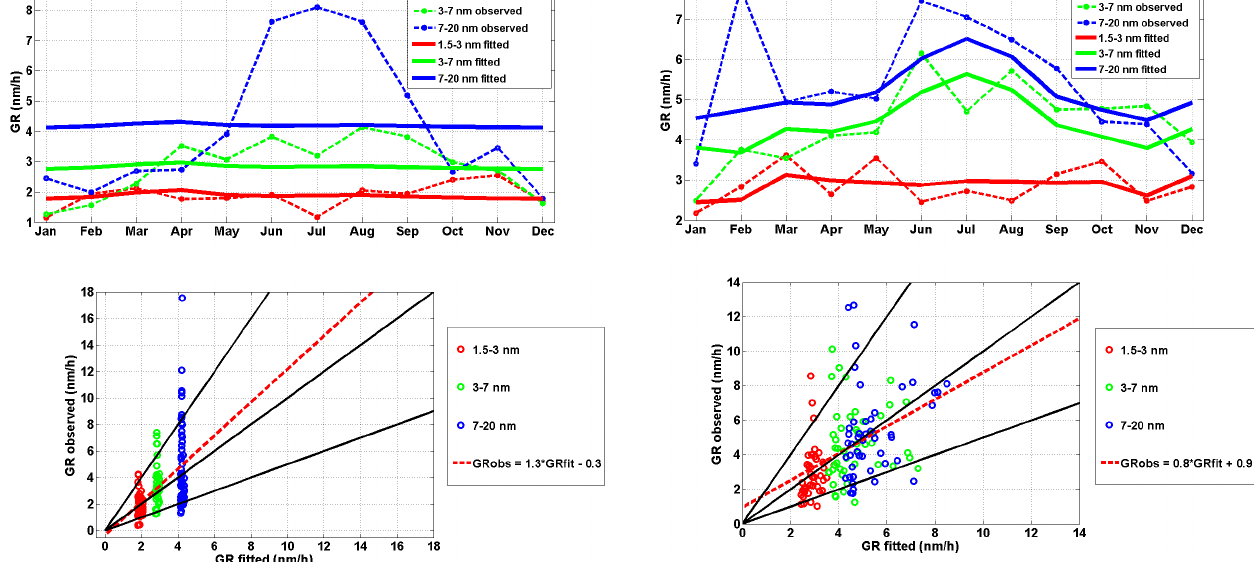
Fig. 5. Observed monthly median growth rates for three size classes during 2003–2009 in Hyyti¨al¨a (symbols and dashed lines) as well as the growth rates obtained from the mass flux fit (solid lines) when organic mass flux ( I SORG , MT ) is assumed to be zero (up- per panel). The background concentration obtained from the fit was C SORG , bg = 5 . 7 × 10 7 cm − 3 with weighing factors for SORG bg 0.2 for 1.5–3nm, 0.6 for 3–7nm and 1 for 7–20nm. The correspon- dence between the growth rates from the mass flux fit and from the ambient observations is presented in the lower panel with a linear curve fitted to all the data points. Also, 1 : 1, 2 : 1 and 1 : 2 lines (black lines) are shown. The seasonal behavior in 3–20nm particles cannot be captured this way.